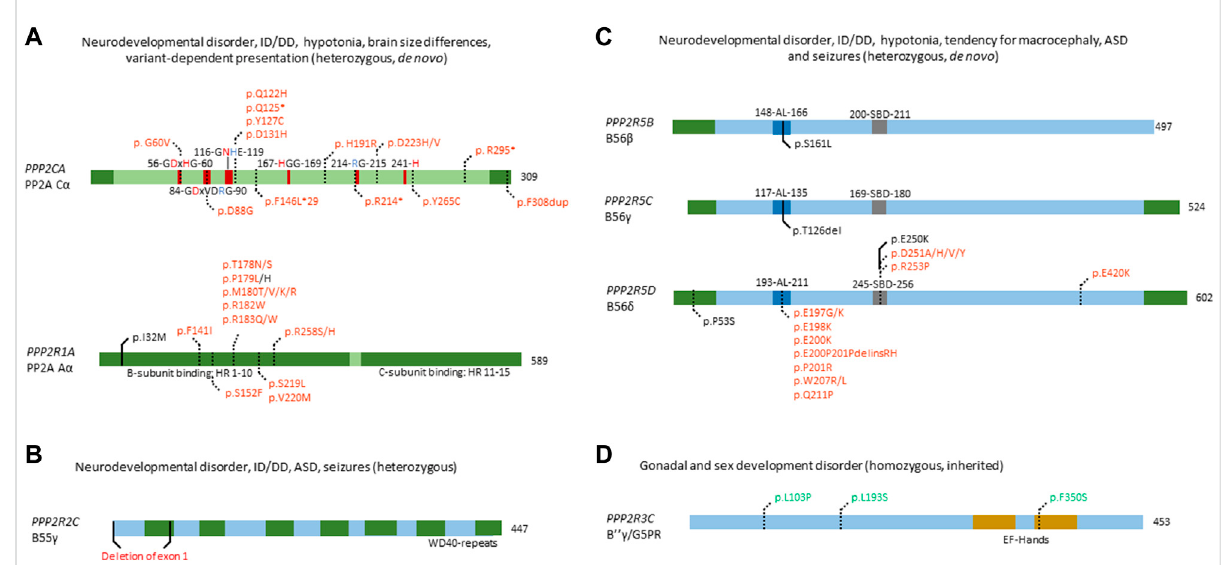
FIGURE 3 Overview of congenital disease-causing variants in subunits of PP2A. (A – C) Overview of variants in PP2A phosphatase genes related to neurodevelopmental delay and intellectual disability. (A) Mutations in PPP2CA and PPP2R1A , encoding the catalytic C α and the structural A α subunit, respectively, are indicated - as well as conserved residues in the catalytic subunit (red amino acids denote metal binding, blue denote phosphate binding),andtheHEAT-repeats(HR)intheA-subunitthatmediatebindingtotheC-andB-subunits.Variantsingreendenotealleged orproven gain-of-function mutants, variants in red: loss-of-function mutants, variants in black: pathogenic mechanism unknown. Dotted lines near variants denote that functional or molecular data have been reported. (B) Partial gene deletion of PPP2R2C (encoding B55 γ regulatory subunit) causes an autosomal dominant intellectual disability syndrome. WD40 repeat: structural domain rich in Trp and Asp residues. (C) Mutations in PPP2R5B (encoding B56 β ), PPP2R5C (encoding B56 γ ) and PPP2R5D (encoding B56 δ ) all cause an ID/NDD disorder, often associated with macrocephaly. B56subunitconserveddomainsandtheirresiduenumberingareindicated:AL,acidicloop;SBD,SLIM-bindingdomain.Variantsinreddenoteproven loss-of-functionmutants.Dottedlinesnearvariantsdenotethatmoleculardataweregathered,inmostcaseshavingprovenpathogenicity. (D) PP2A phosphatasegenesrelatedtodevelopmentalabnormalitiesinnon-neuraltissues.Homozygousvariantsof PPP2R3C ,encodingB ″ γ orG5PR,causea gonadal and sex developmental syndrome. EF-hands: canonical Ca 2+ -binding motif. Variants in green denote alleged or proven gain-of-function mutants. Dotted lines near variants denote that functional data have proven